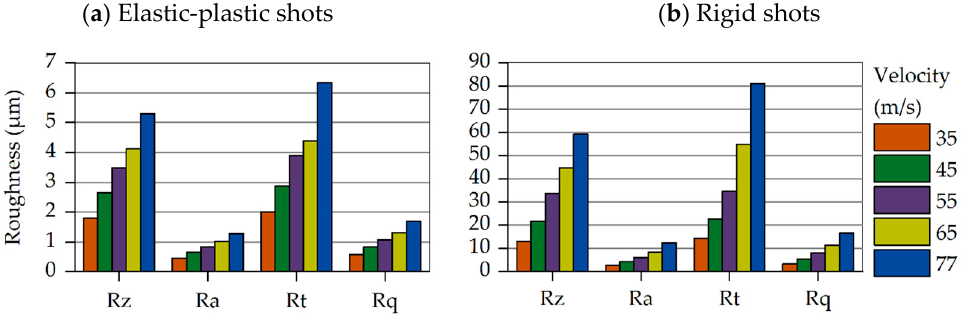
Figure 5. Roughness values for variable impact velocity: Elastic-plastic and rigid (non-deformable) shots approximation. ( a ) Elastic-plastic shots; ( b ) Rigid shots.